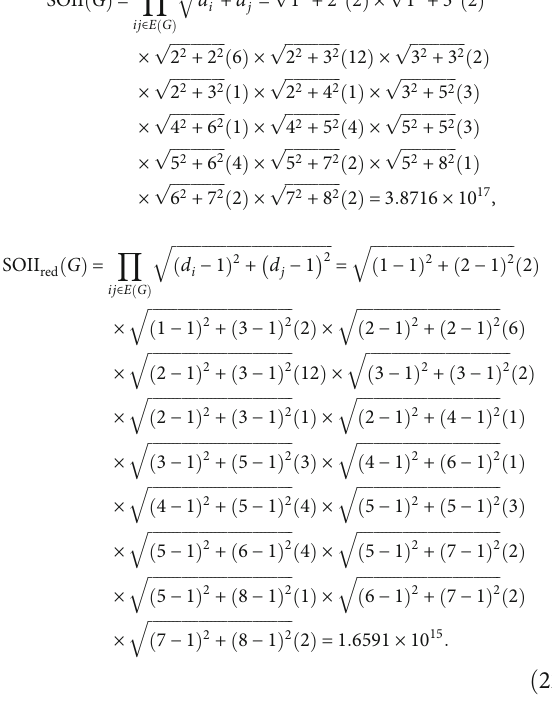
2 ð Þ 2 ð Þ 3 ð Þ 3 ð Þ 1 ð Þ